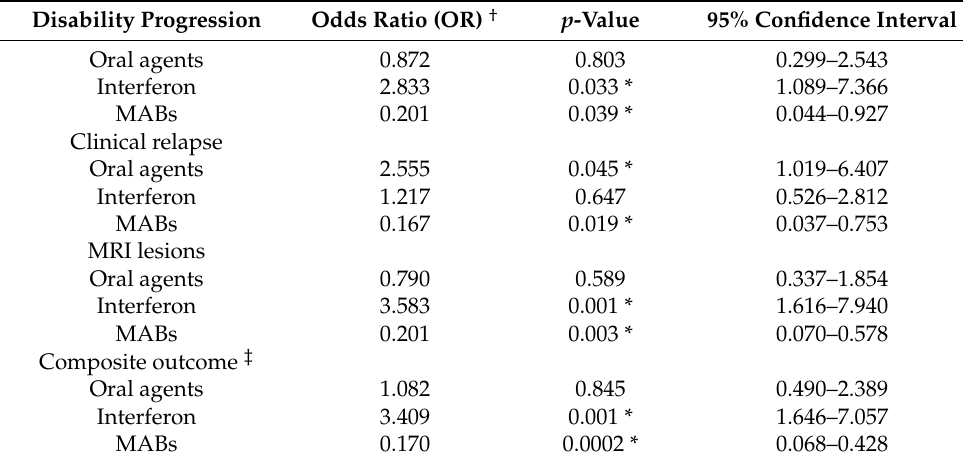
Table 2. The odds of disability progression, clinical relapse, and lesions on magnetic resonance imaging